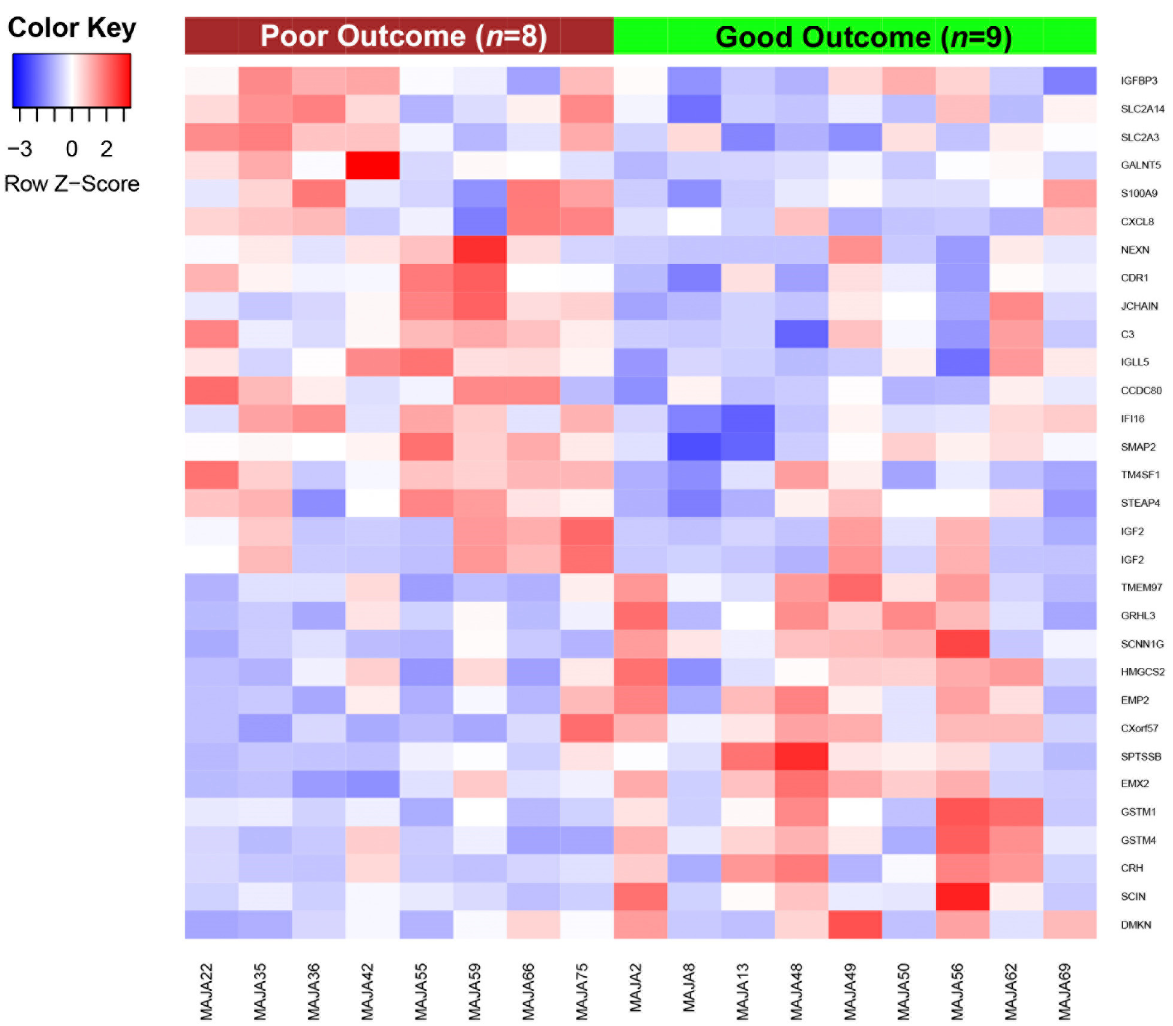
Figure 1. Gene expression patterns associated with vinflunine resistance in aUCC patients. Heat map depicting the normalized expression of the 31 genes differentially expressed between patients with good and poor outcome to vinflunine treatment, obtained from an adjusted linear model (|FC| > 1.5 and p ≤ 0.05). IGF2 appears twice in the heatmap as two different transcripts of this gene were identified in the microarray analysis.